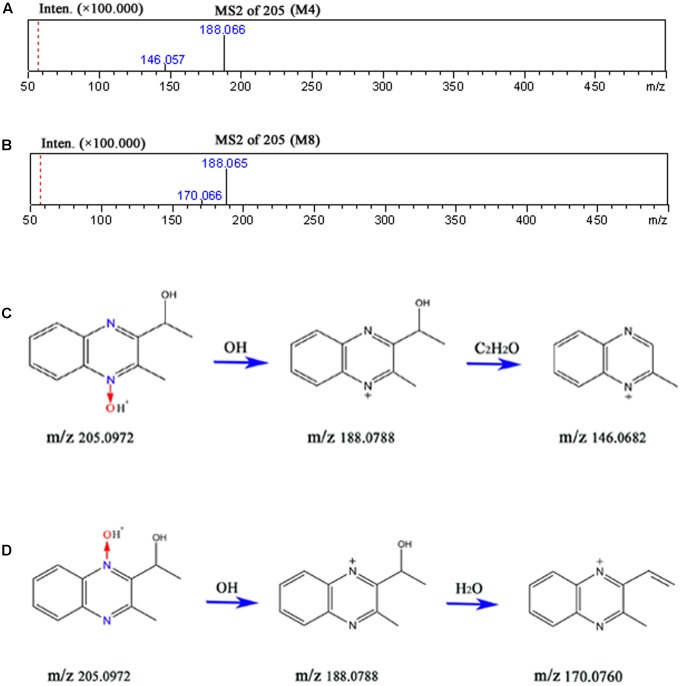
The accurate MS2 spectral for M4 (A) and M8 (B), and proposed fragmentation pathways of M4 (C) and M8 (D).